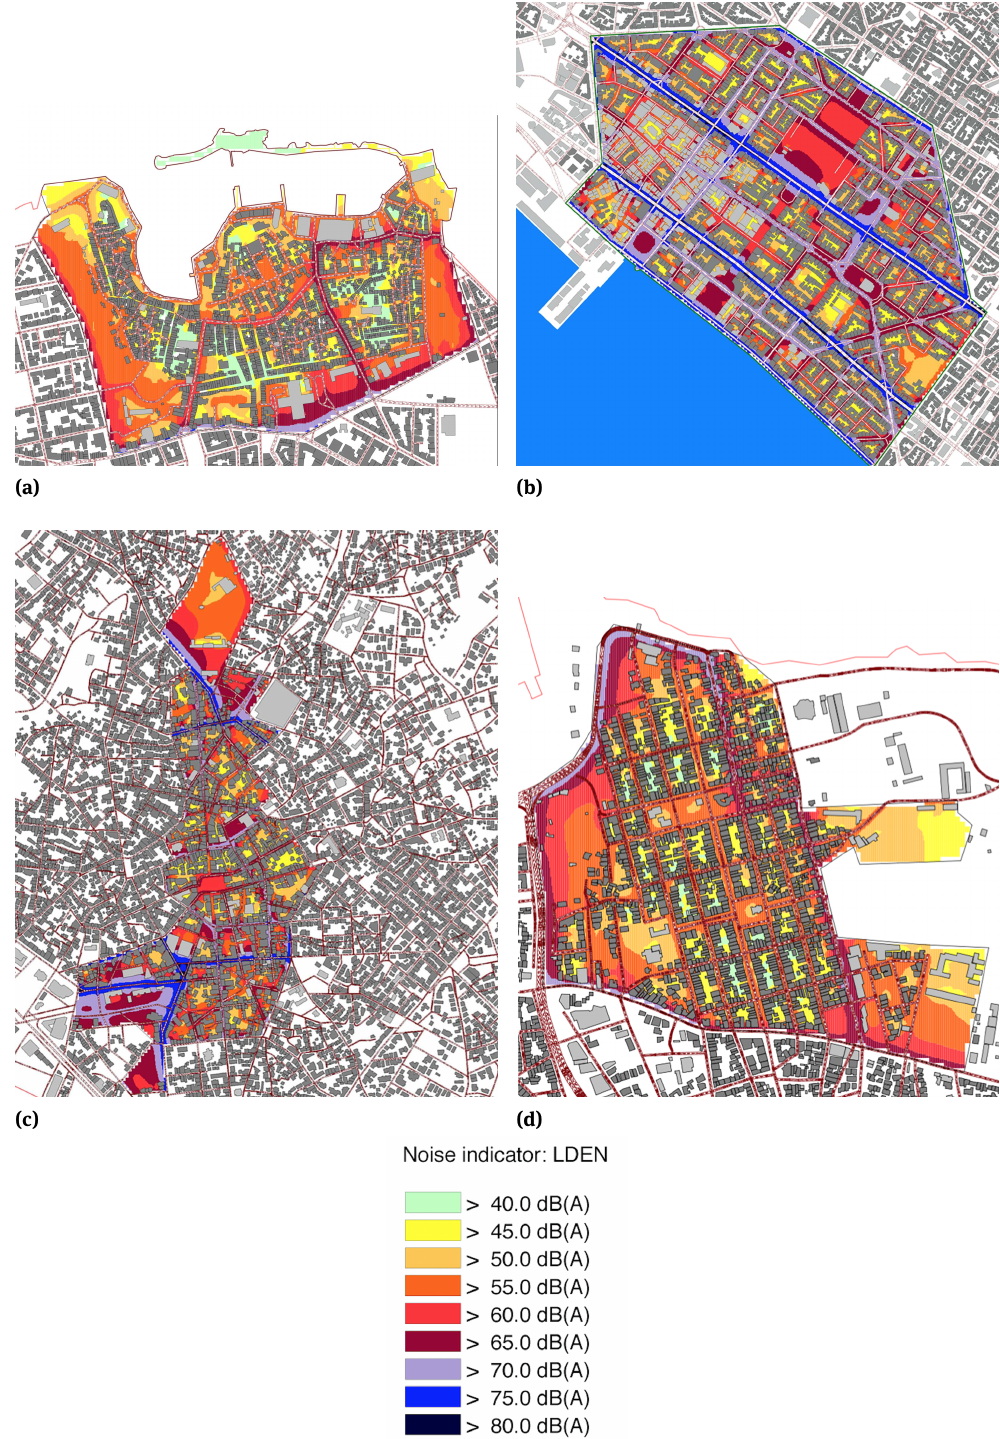
Figure 3: S.N.M (road) of (a) Chania urban centre and port (2013), (b) Thessaloniki Historical City centre, (c) Agrinio city centre and (d) the Alikarnassos district at Heraklio UA, - Noise index L den